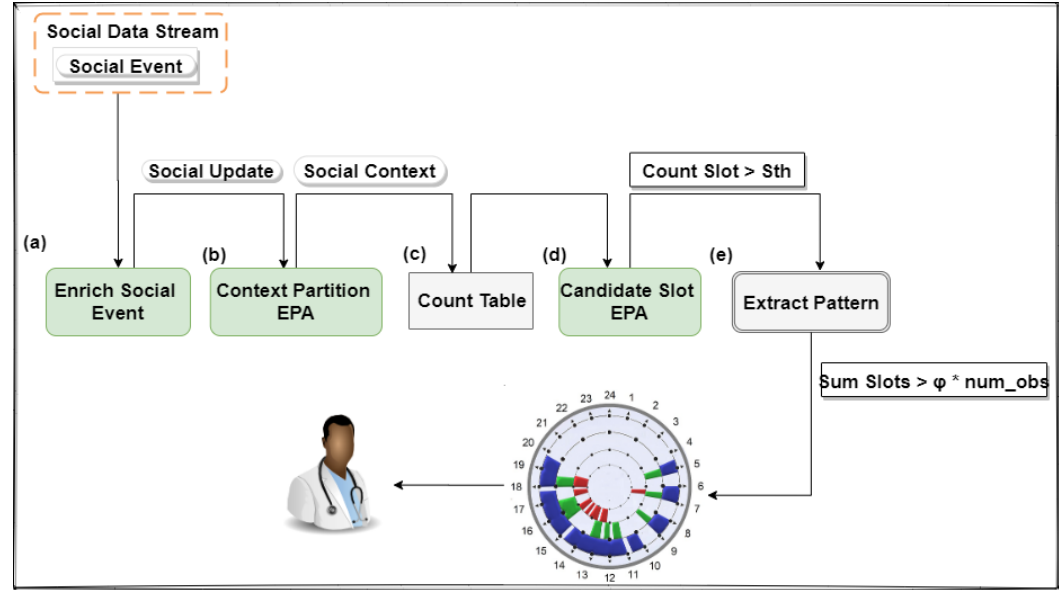
Figure 2. Processing